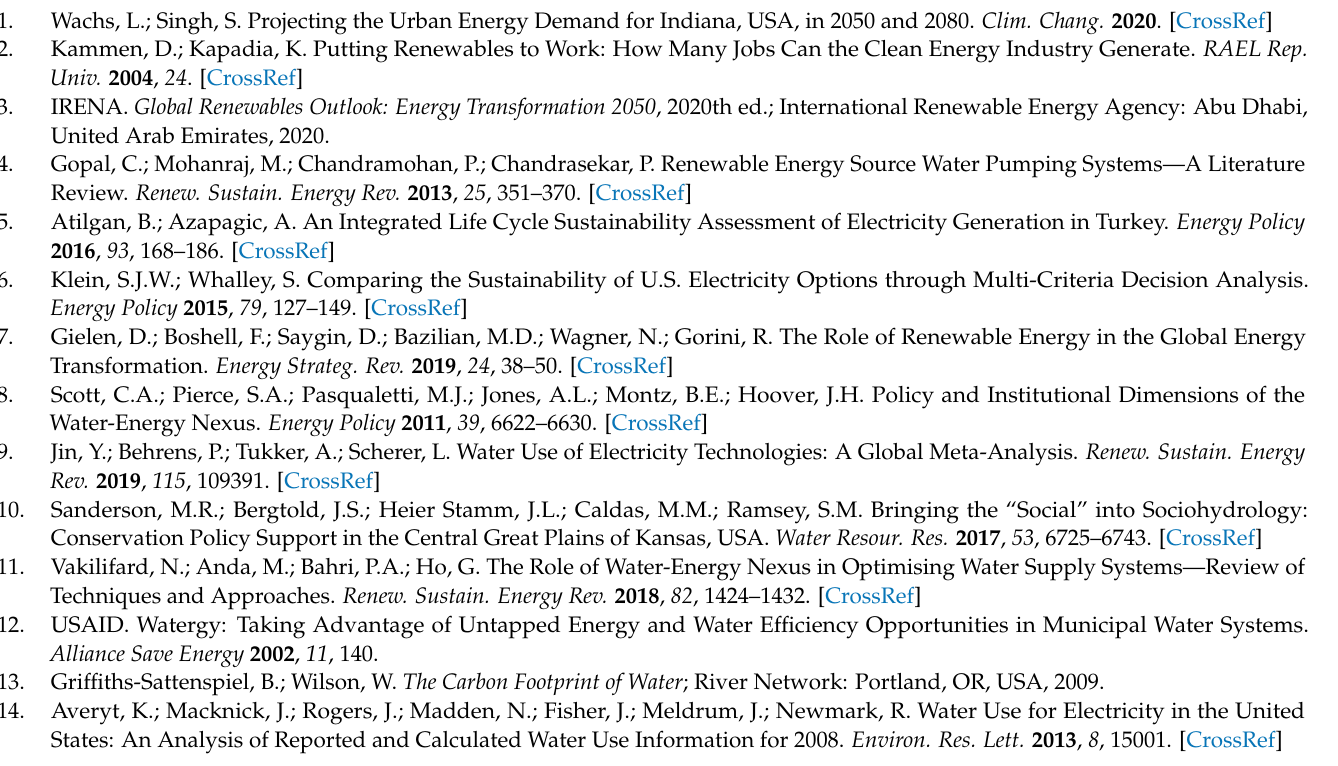
Figure S2: Temporal energy consumed per net electricity generated by energy source, Figure S3: Temporal net electricity production by energy source, Figure S4: Temporal changes in total generator nameplate capacity by energy source, Table S1: Average annual CO 2 , SO 2 and NO x emission rates for petroleum, natural gas and